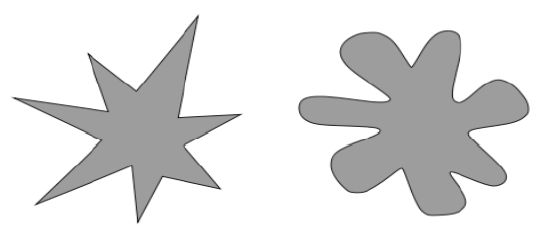
Figure 6. ( Left ) kiki: angular, jagged shapes; ( Right ) bouba: smooth, rounded shapes [146]. Adeli et al. [147] investigated the cross-modal correspondences between musical timbre and shapes. One hundred and nineteen subjects (31 females and 88 males) participated in the online experiment. Subjects included 36 claimed professional musicians, 47 claimed amateur musicians, and 36 claimed non-musicians. Thirty-one subjects have also claimed to have synesthesia-like experiences. Subjects have strongly associated soft timbres with blue, green or light gray rounded shapes, harsh timbres with red, yellow or dark gray sharp angular shapes. This is consistent with Kiki–Bouba experiment where subjects mostly chose a jagged shape for Kiki and a rounded shape for Bouba [145–148]. It is also consistent with Parise’s findings [148] where subjects associated sine waves (soft sounds) with a rounded shape and square waves with a sharp angular shape